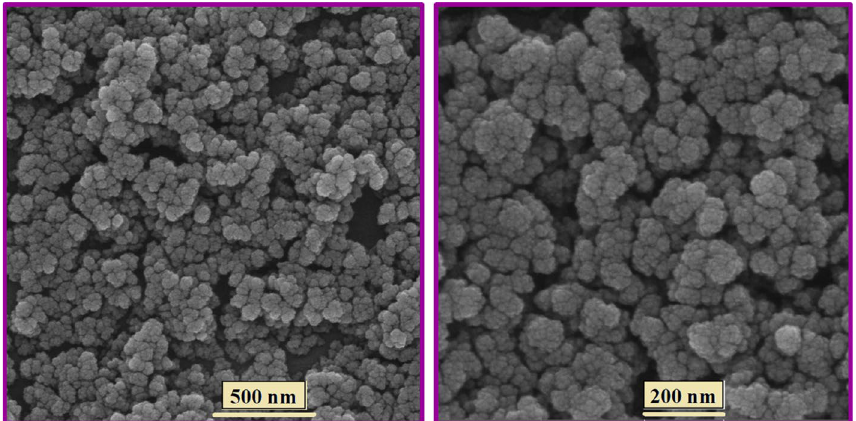
Figure 6. FE-SEM images of the Zr-UiO-66-PDC MOF.